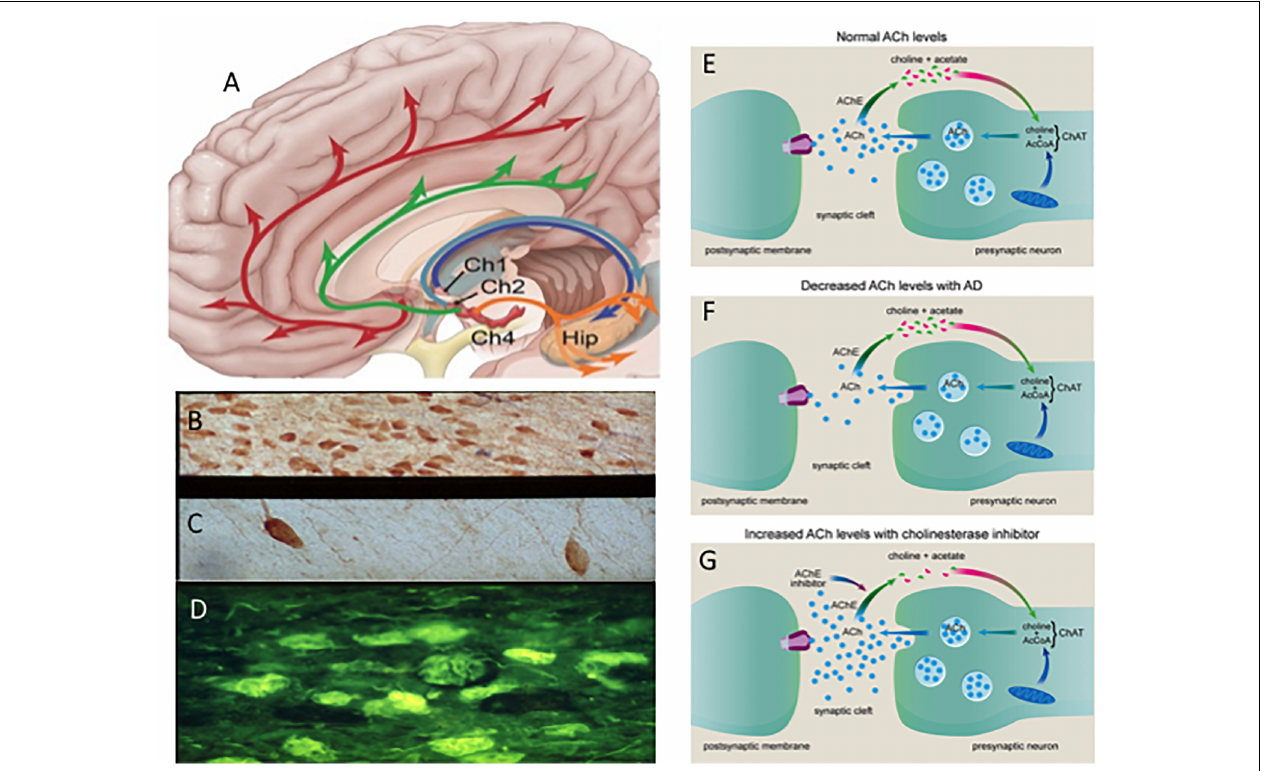
FIGURE 2 | (A) Schematic drawing of the cholinotrophic cortical and hippocampal projection systems. Photomicrographs showing images of cholinotrophic neurons in an aged control (B) , reduction in AD (C) and thioflavin (yellow) tangle-bearing p75 NTR neurons (dark blue) (D) in AD. Cartoon showing changes in acetylcholine (ACh) between a normal (E) and AD (F) and the effect of acetylcholinesterase inhibitors at the cholinergic synapse (G) . Ch1, medial septal cholinergic cell group; Ch2, vertical limb of the diagonal band cholinergic cell group Ch4; nucleus basalis cholinergic cell group and Hip, hippocampus. Red and green arrows indicate bilateral Ch4 projections; dark blue and light blue arrows indicate septal/diagonal band projections to the